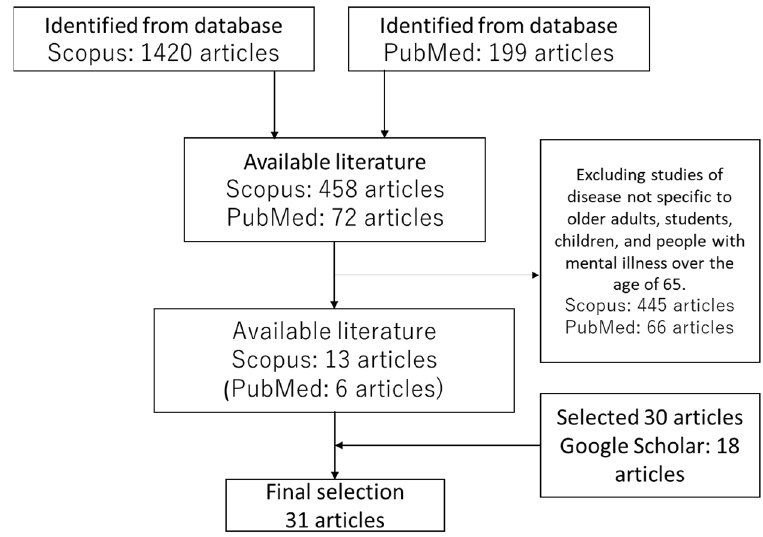
Figure 1. Flowchart describing the target literature search for final selection.